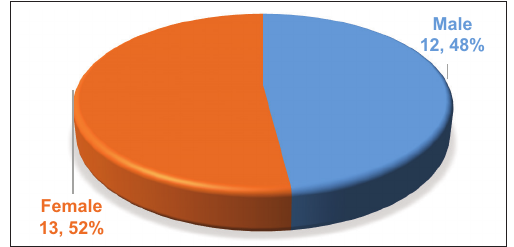
CHART 1. Gender structure of respondents.(male12.48% female 13.52%)